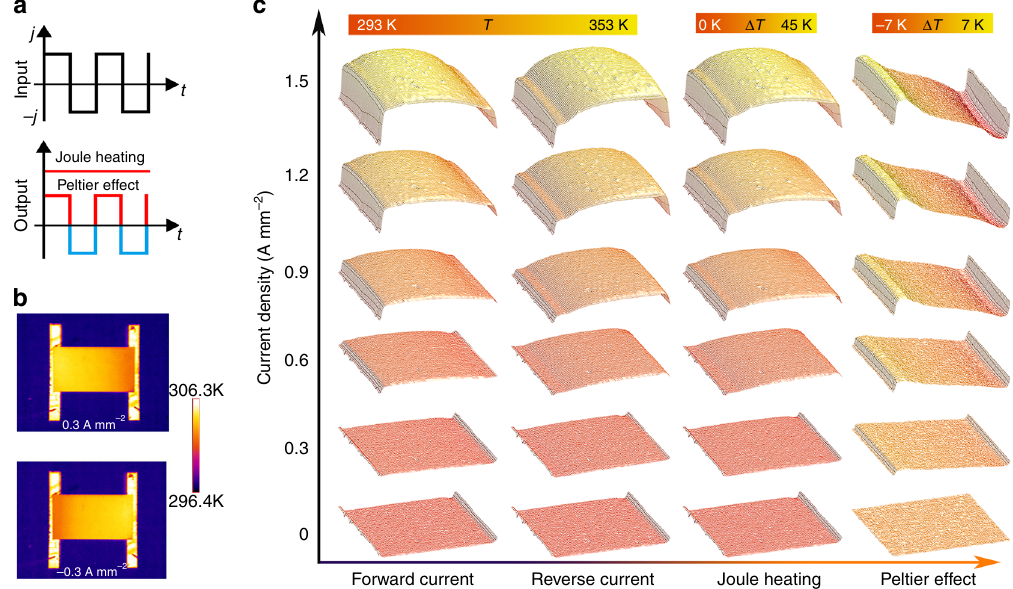
Fig. 2 Imaging of the Joule heating and Peltier effects of an organic thermoelectric (OTE) device. a A schematic illustration of the mechanism for separating Joule heating and the Peltier effect. The Peltier effect and Joule heating are odd and even functions of the applied current, respectively. When a rectangular alternating current is applied, the direction of the temperature distribution induced by the Peltier effect changes with the current, whereas the Joule- heating-induced temperature distribution remains constant. b Infrared image of an OTE device with a current of ±0.3 A mm − 2 . Current fl ow from the left electrode to the right electrode is de fi ned as the forward direction ( + ) and vice versa ( − ). c Temperature distribution of an OTE device under different currents and the separate contributions of Joule heating and the Peltier effect to the temperature of the fi lm. The sharp temperature drop of the exposed electrodes arises from low emissivity of gold electrodes